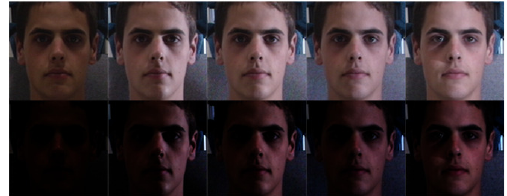
Figure 1. Some poor-lighted faces under various illumination